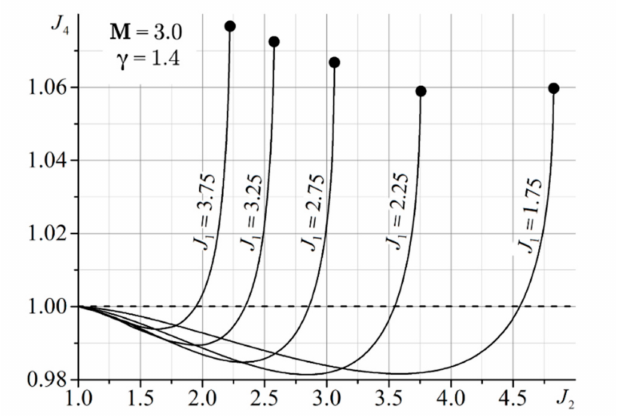
Figure 16. Dependence of the intensity of reflected discontinuity J 4 on the intensity of the first J 1 and second J 2 overtaking shocks for M = 3.